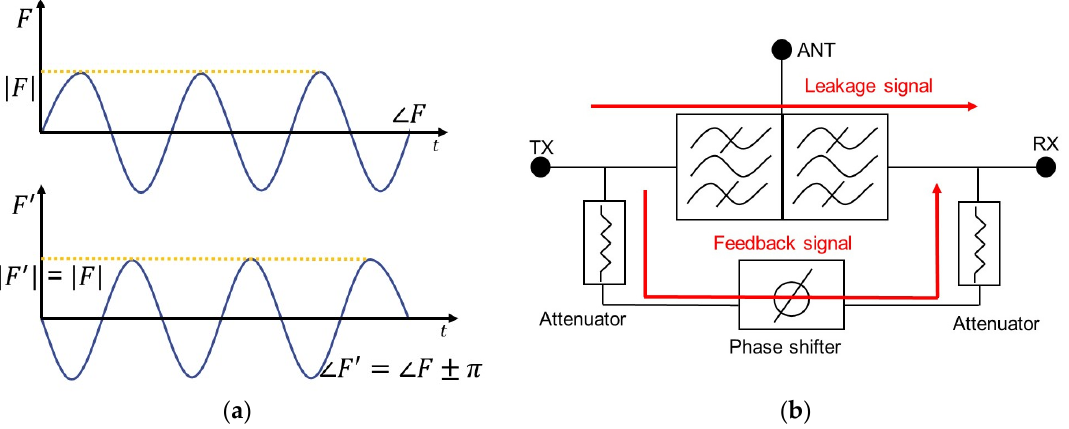
Figure 3. The principle of the phase canceling circuit. ( a ) The requirements of the feedback signal. The blue one is leakage signal and feedback signal. The yellow one is the amplitude. ( b ) The schematic diagram of phase canceling circuit.